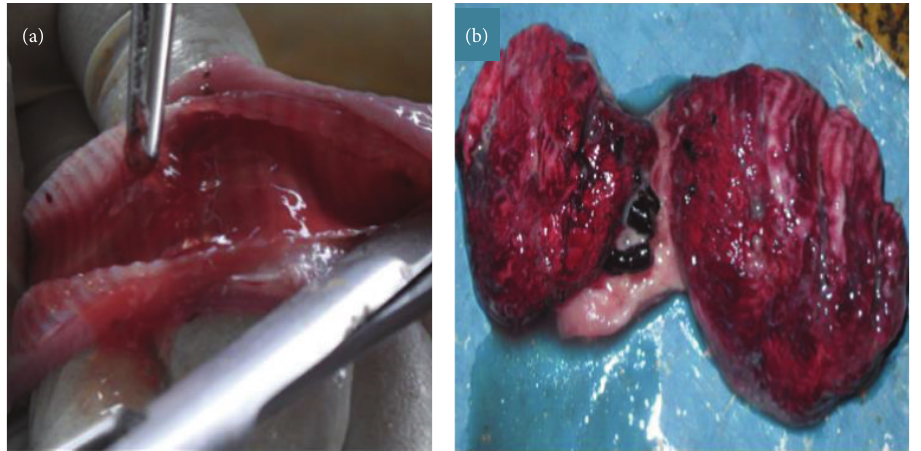
Figure 3: Gross lesions observed on respiratory organs of chicken naturally infected with IBV. Presence of mucoid secretion, congestion, and hyperaemia in the trachea (a); mild focal areas of lung consolidation (b).